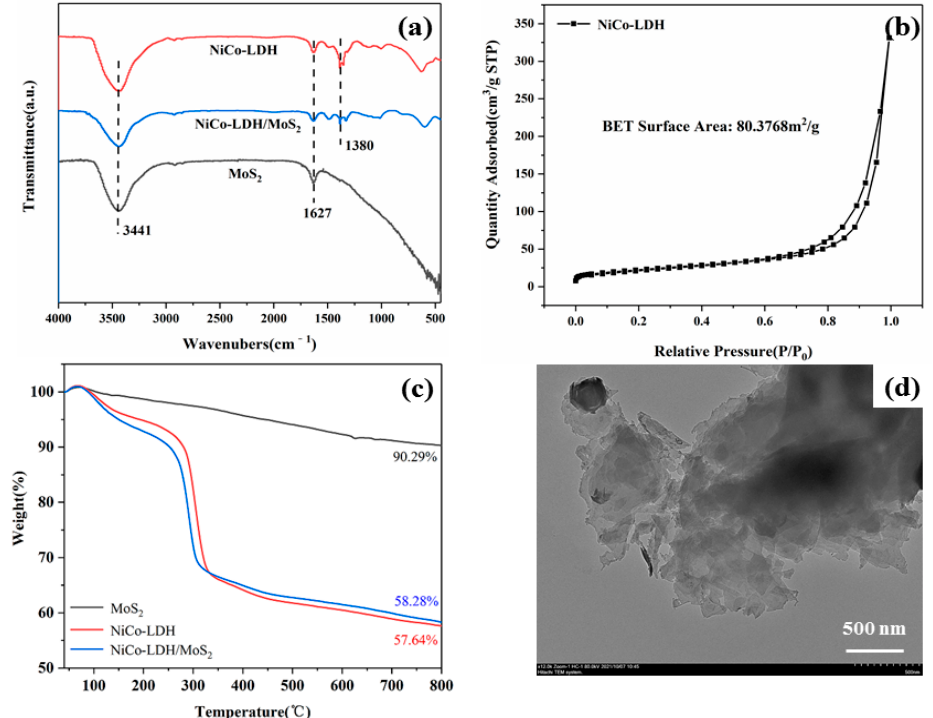
Figure 3. FTIR spectra of MoS 2 , NiCo-LDH and NiCo-LDH/MoS 2 ( a ); N 2 adsorption − desorption isotherms of NiCo-LDH ( b ); TG curves of MoS 2 , NiCo-LDH and NiCo-LDH/MoS 2 ( c ); TEM image of MoS 2 ( d ).